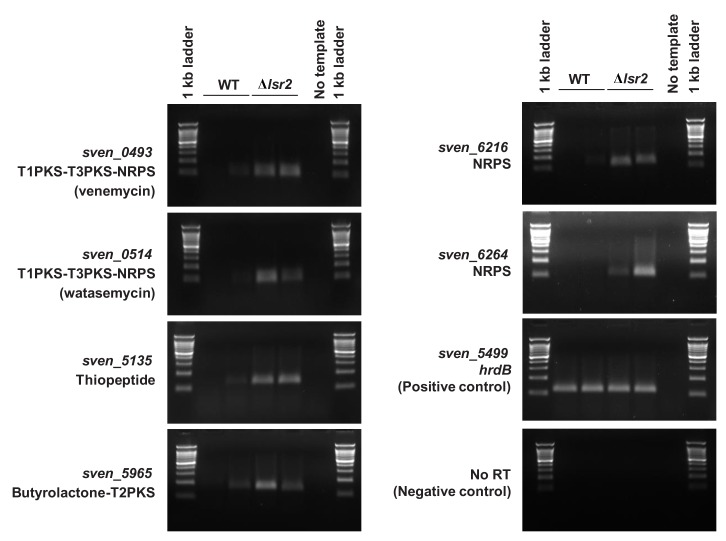
Semi-quantitative RT-PCR using RNA (biological replicates) isolated from S. venezuelae wild type (WT) or ∆lsr2 in early stationary phase.sven_0493, sven_0514, sven_5135, sven_5965, sven_6216 and sven_6264 are genes predicted to be located within different specialized metabolic gene clusters by antiSMASH 4.0 (Blin et al., 2017). Primers annealing within the constitutively expressed vegetative sigma factor hrdB were used as a positive control for RNA abundance and integrity. No-RT reactions (RNA template) and no-template reactions served as controls for DNA contamination.